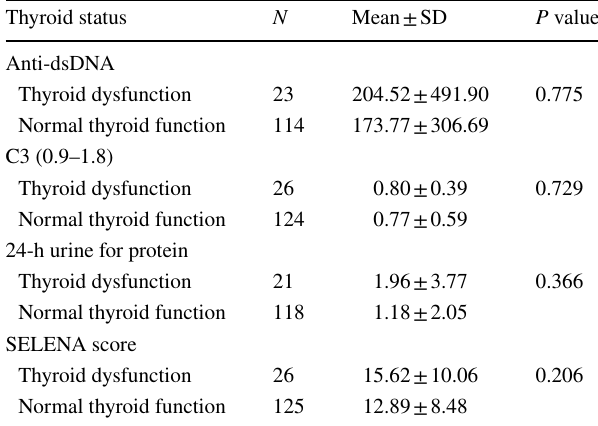
Table 3 Association between thyroid dysfunction and SLE disease activity